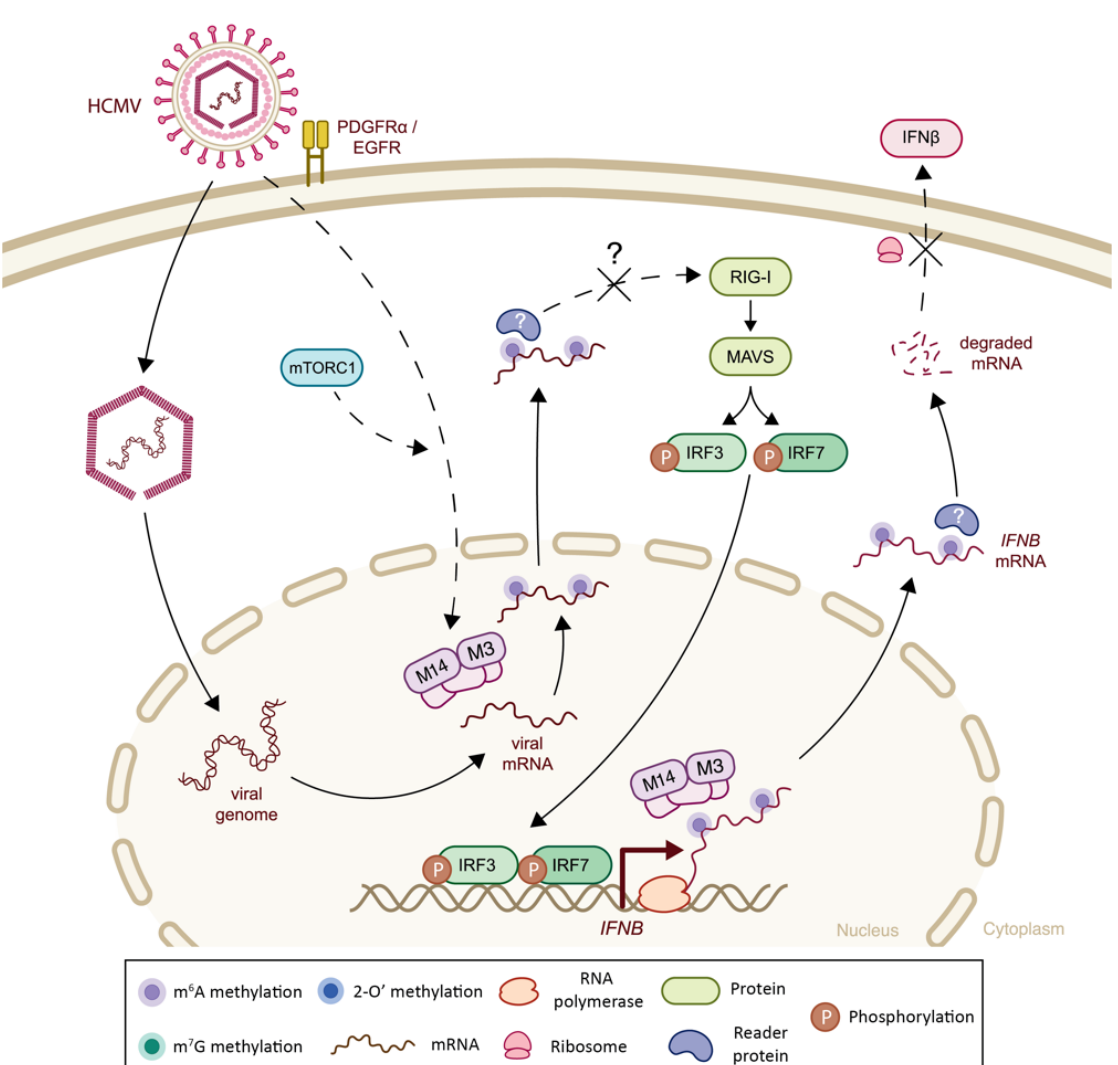
Figure 8. The impact of epitranscriptomic methylations on IFN-I response during HCMV infection. A double-stranded DNA genome of human cytomegalovirus (HCMV) is transcribed into viral mRNAs in the nucleus, after cellular entry. Viral transcripts are co-transcriptionally m 6 A-methylated (filled purple circles) by cellular m 6 A machinery. After HCMV infection, the m 6 A writer complex is upregulated, which is linked to HCMV-driven mTOR activation. M 6 A-methylated viral transcripts may avoid RIG-I sensing. HCMV infection also alters the IFNB m 6 A pattern. The m 6 A methylation of IFNB mRNA decreases its mRNA stability and thus IFN β levels, supposedly via YTHDF2 interaction (F2, light blue). F1: YTHDF1; F2: YTHDF2; F3: YTHDF3; M3: METTL3 ; M14: METTL14.